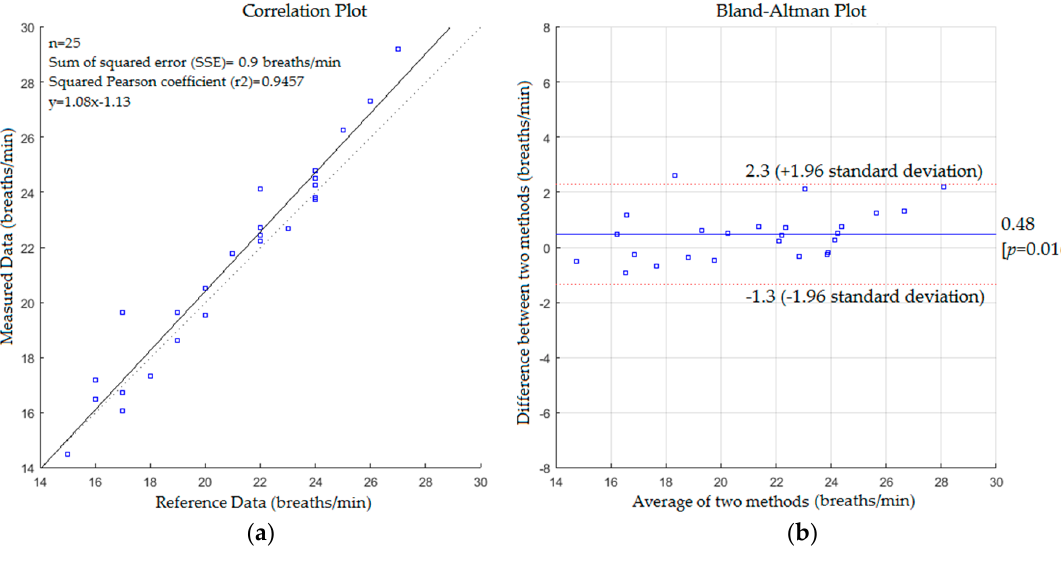
Figure 12. ( a ) Correlation plot; ( b ) Bland-Altman plot of the difference between measured data and reference data (second scenario with a blanket).